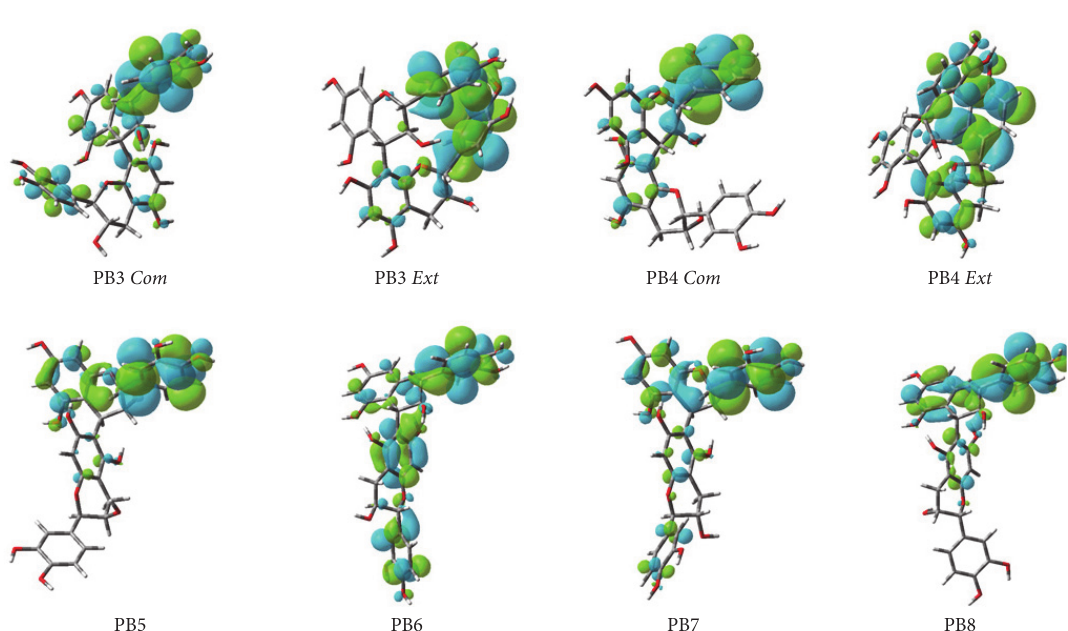
Figure 4: Charge distribution in the LUMO orbital of the procyanidin dimers optimized in aqueous medium (SMD model) using the M05- 2X/6- 31 G ∗∗ DFT method. Com : compact conformation; Ext : extended conformation.